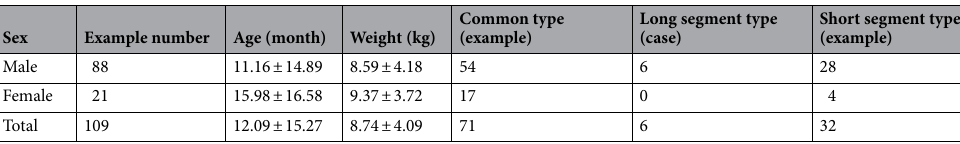
Table 1. Demographics of the